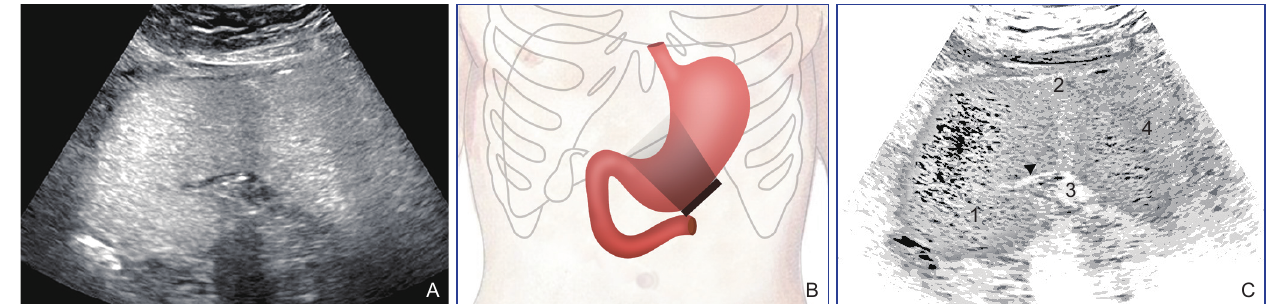
Figure 11 Ultrasonogram and schematic diagram of coronal section of the gastric corner (scan through the upper left umbilicus). A. Ultrasonogram. B. Schematic diagram, C. Schematic diagram of ultrasound (1. Anterior wall of stomach, 2. Great curvature, 3. Lesser curvature, 4. Gastric body; ▼ stomach